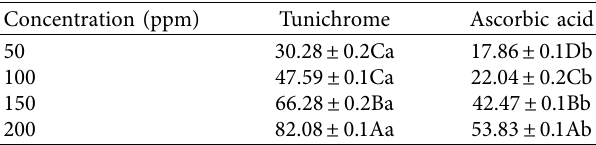
Data represent mean ± standard deviation of three independent repeats. Different capital letters in each column and lowercase ones in each row indicate significant differences ( P < 0.05). Table 8: Inhibition zones (mm) of tunichrome released from Phallusia nigra Persian Gulf marine tunicate (150 μ g/ml) and gentamicin (10 μ g/ml).